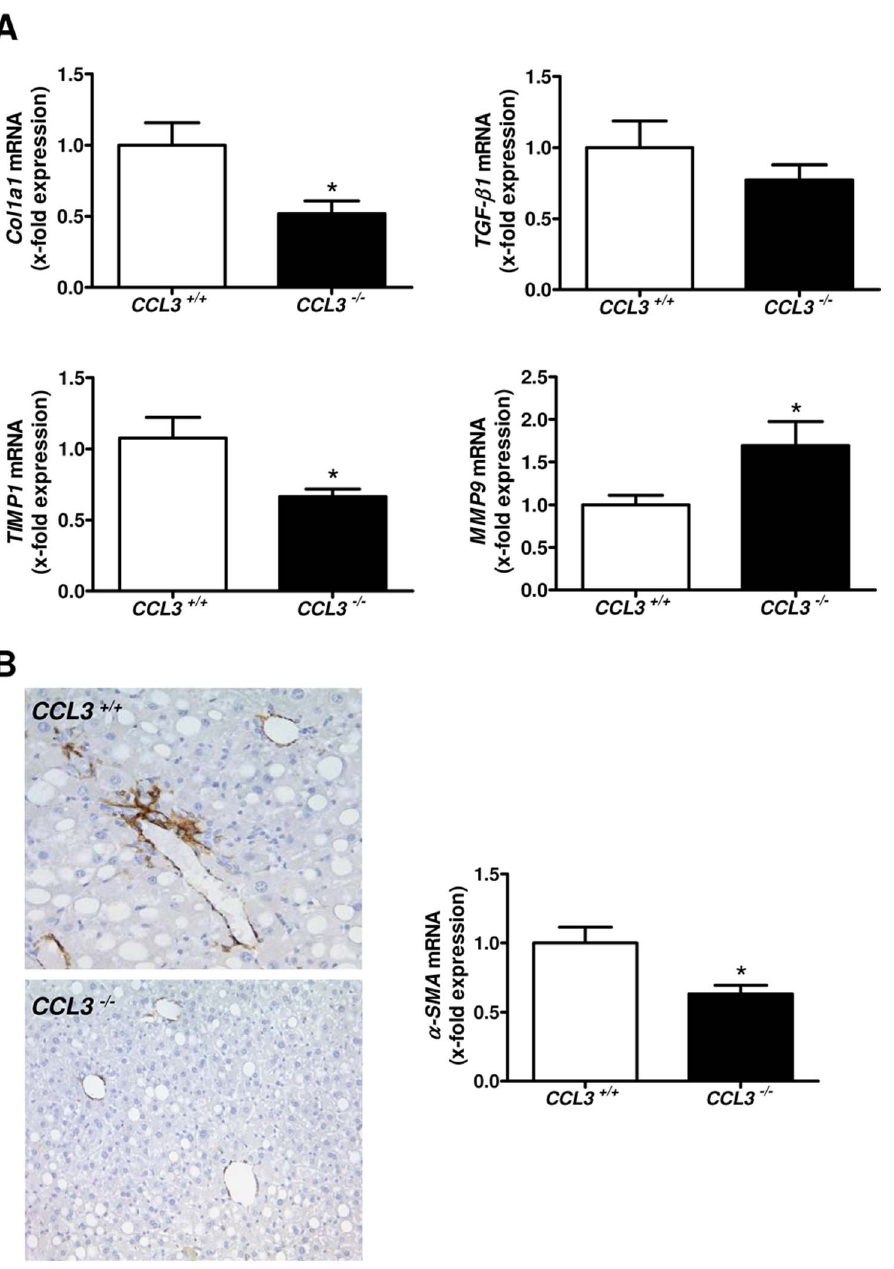
Figure 2. Fibrosis-related genes after eight weeks of MCD diet. MCD-fed CCL3 2 / 2 mice show a significantly altered expression of the fibrosis- related genes Col1a1 , TIMP1 and MMP9 compared to wild-type mice. However, mRNA expression of TGF- b 1 does not vary in CCL3 2 / 2 mice ( A ). a -SMA expression is significantly decreased in CCL3 2 / 2 mice after MCD diet. Representative a -SMA staining is shown in the left panel (x100 magnification, B ). Data are expressed as means 6 SEM of eight mice per group. * P ,